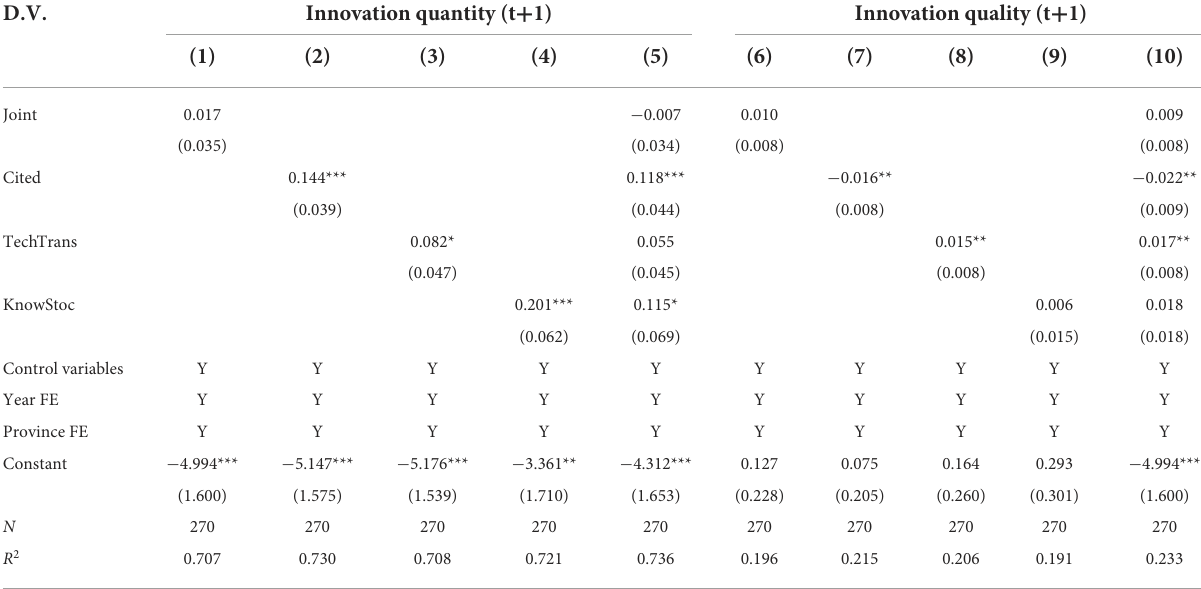
TABLE 3 The heterogeneous impact of knowledge spillover channels in universities on the quantity and quality of green innovation (t+1).